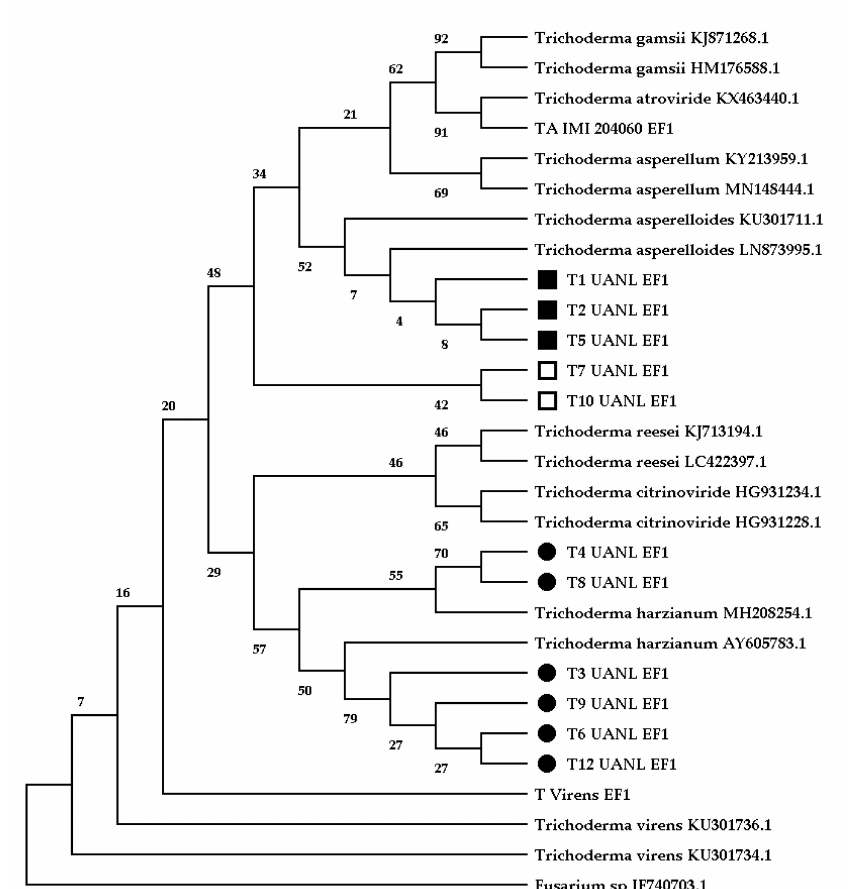
Figure 1. Phylogenetic analysis of Trichoderma with the molecular marker TEF1 (section 728–1567) with the neighbor-joining method. The optimal tree with the sum of the branch length = 2.72 is shown. The analysis was performed in MEGA 11. The percentage of replicate trees in which the associated taxa clustered together in the bootstrap test is shown (1000